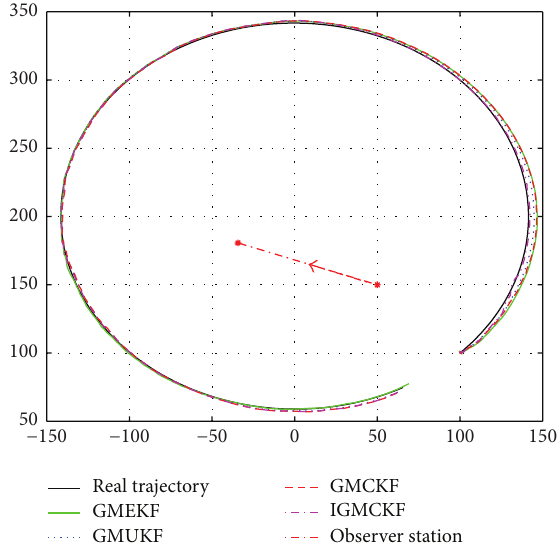
Figure 1: Comparison of the trajectory estimations.